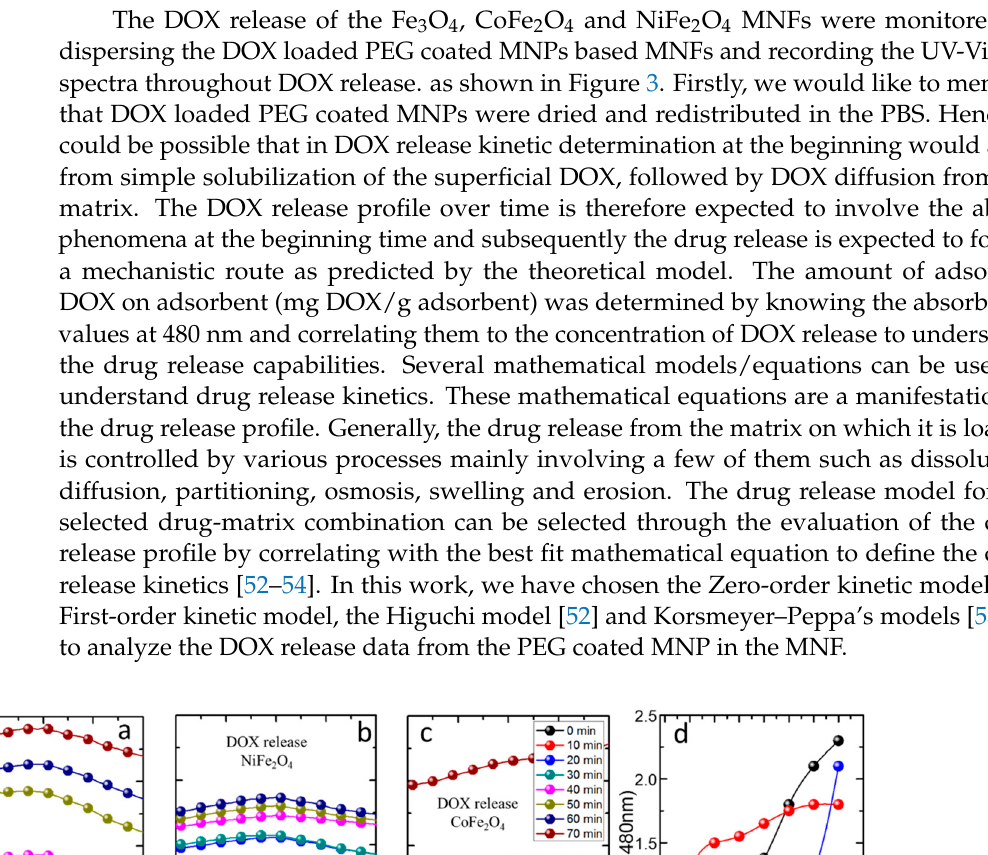
Figure 4. DOX release: ( a ) Zero-order, ( b ) First-order, ( c ) Higuchi and ( d ) Korsmeyer–Peppa’s kinetic model pro- files of PEG Coated MNPs in PBS buffer solution. The R and R 2 values of the four model plots that correspond to PEG coated CoFe 2 O 4 , PEG coated NiFe 2 O 4 and PEG coatedFe 3 O 4 are presented in Table 1 along with the model parameters if any. The R 2 value was used as the guideline to predict the drug release ki- netics and associated mechanism. The best R 2 for PEG coated CoFe 2 O 4 is found to be 0.9839 (Table 1) following Korsmeyer–Peppa’s model. The n value of 0.5475 informs the predom- inance of non-Fickian diffusion (anomalous) for DOX release from PEG coatedCoFe 2 O 4 . The anomalous non-Fickian diffusion is correlated with the combination of both diffu- sions of the DOX and dissolution of PEG, which suggests the hypothesis that DOX release from PEG coated CoFe 2 O 4 is driven by both diffusion and PEG dissolution [57]. In the case of NF based on PEG coated Fe 3 O 4 , the best R 2 amongst the four models is 0.9727, and hence Korsmeyer–Peppa’s model is the best fit to explain DOX release. The higher n value than unity (1.1015, Table 1) informs the possible operation of a super transport II mechanism supporting the combination of relaxation and erosion [58]. The DOX release from poly (acrylic acid) coated magnetite nanoparticles followed the super transport II mechanism [59]. In the case of PEG coatedNiFe 2 O 4 , the best R 2 is for zero-order DOX release. Generally, it is good to develop drug carriers that can have sustained or controlled drug release with a minimum dosing frequency. Drug delivery systems that follow zero-order kinetics, too, release a regular/constant/consistent amount of drug per